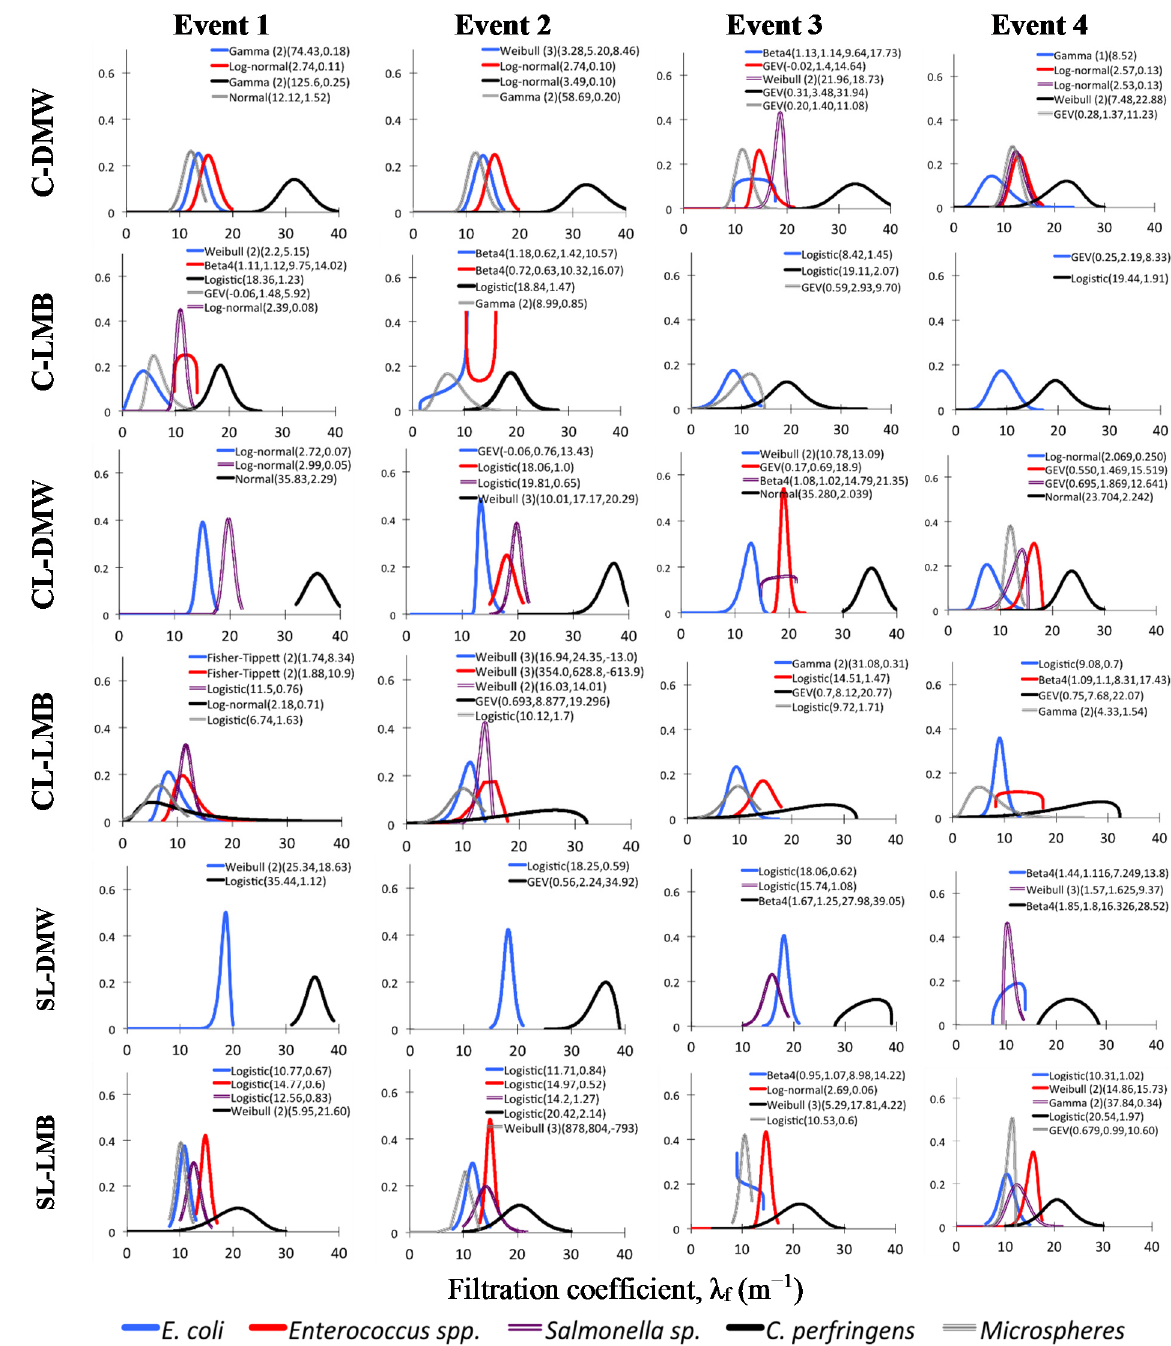
Figure 5. Best-fit density distributions for cumulative filtration coefficients.